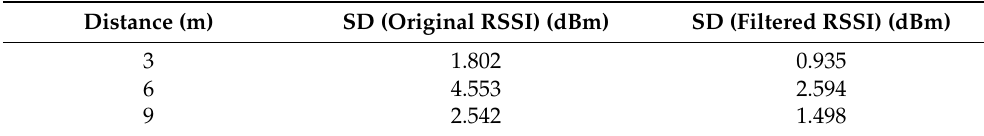
Table 1. Standard deviation (SD) of received signal strength indication (RSSI) at 3, 6, and 9 m before and after